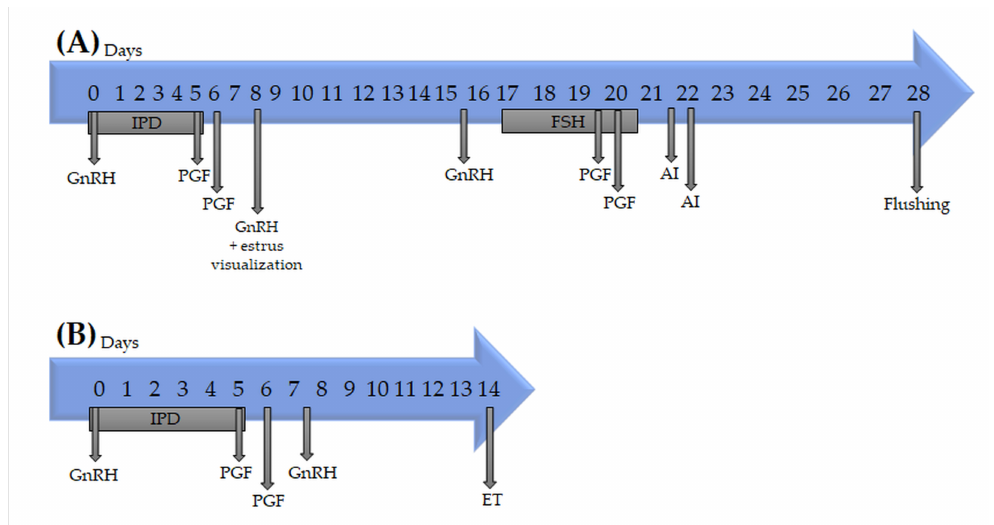
Figure 1. Hormonal protocols for superovulation and flushing in donors ( A ) and for embryo trans- fer in recipients ( B ). Abbreviations: IPD = intravaginal progesterone device; PGF = prostaglandin; GnRH = gonadorelin; FSH=folliclestimulanthormone; AI=artificialinsemination; ET = embryo